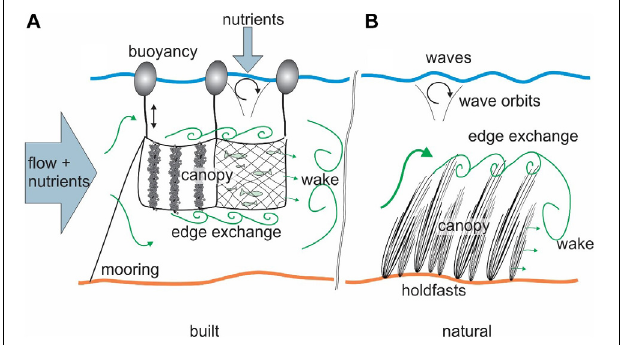
FIGURE 1 | Comparative synthesis diagram showing (A) built (showing both suspended longline shellfish and fish cage examples) and (B) natural (submerged used here as an example) canopies suggesting that while there are similarities in generalities (flow deformation, wakes, shear layers, etc.) there are substantial differences in the details like mooring/holdfast, buoyancy and nutrient supply. The decaying wave orbits in both panels indicate the approximate direct influence of surface